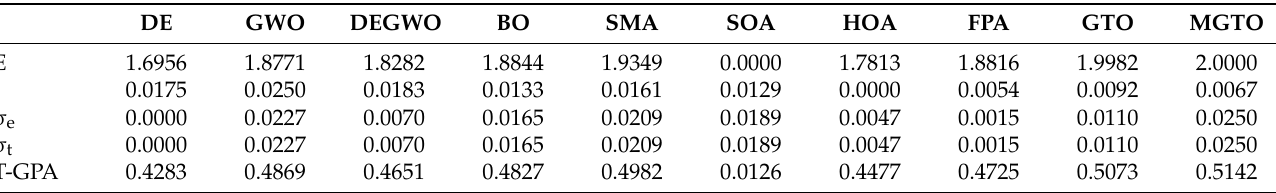
Table 11. Comparison under GPA on test case 3.